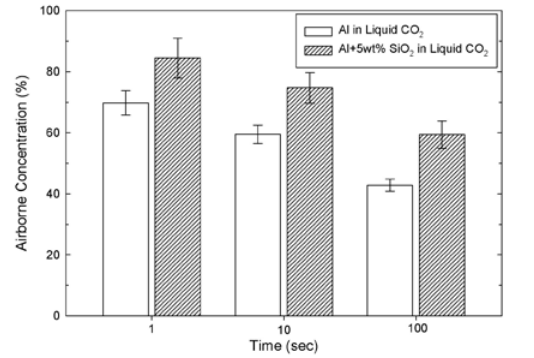
Airborne concentration using liquid carbon dioxide and silica. The addition of 5 wt% silica has previously been shown to re- duce the van der Waals forces between flakes by increasing the interparticle spacing. This also increases the volume of liquid carbon dioxide between the flakes and in turn the amount of pressure that can be generated upon dissemination.